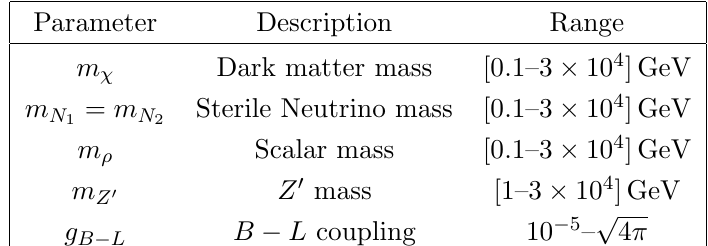
Table 1 . Ranges of the parameters explored in the parameter scan. As discussed in section 4.3, values of m Z 0 were sampled using 200 logarithmically spaced points. For each point random values of m (cid:31) ; m N = m N ; m (cid:26) were drawn from the range detailed in the table above (assuming a log- 1 2 (cid:13)at distribution), and g B (cid:0) L was set to be consistent with the measured relic abundance at 2 (cid:27) , i.e. (cid:10) DM h 2 = 0 : 120 0 : 003 [71]. We further require all Yukawa couplings to be (cid:6) in order for the model to remain perturbative. The total number of points in parameter space